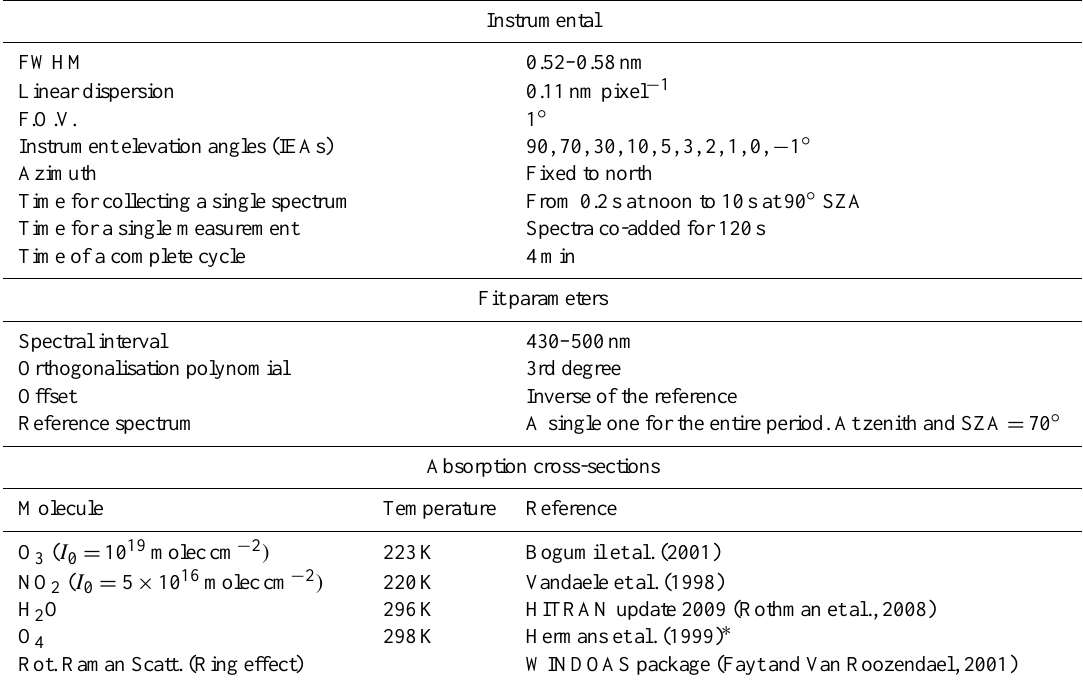
Table 1. Instrumental characteristics and parameters used in the fit of the